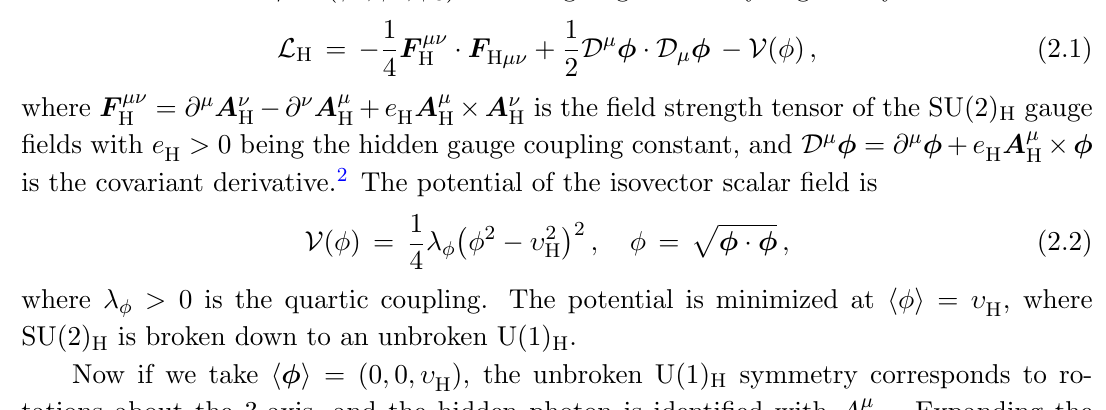
Table 1 . The masses, electric and magnetic charges of the particles in the hidden sector, where (cid:11) = e 2 = (4 (cid:25) ) is the hidden (cid:12)ne structure constant. Here we take the Bogomol’nyi limit for the H H hidden monopole mass and its hidden electric charge is due to the Witten e(cid:11)ect. isovector scalar (cid:12)eld (cid:30) = ( (cid:30) ; (cid:30) ; (cid:30) ). The Lagrangian density is given 1 2 3